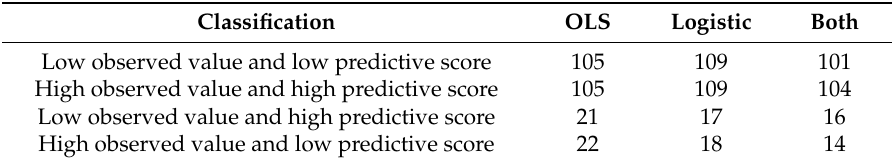
Table 5. Classification results of 253 drivers.